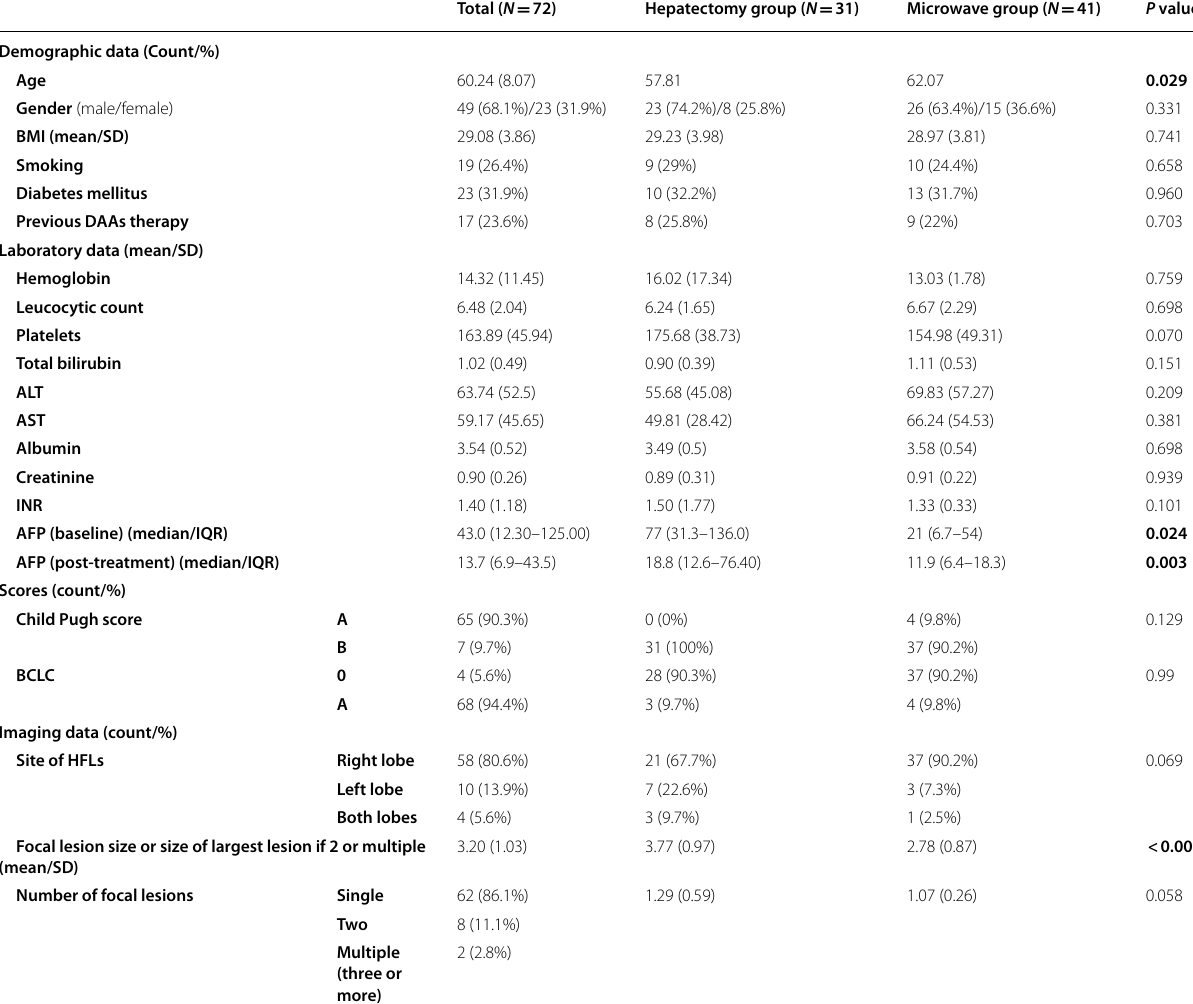
Table 1 Demographic, laboratory, and imaging data of studied population